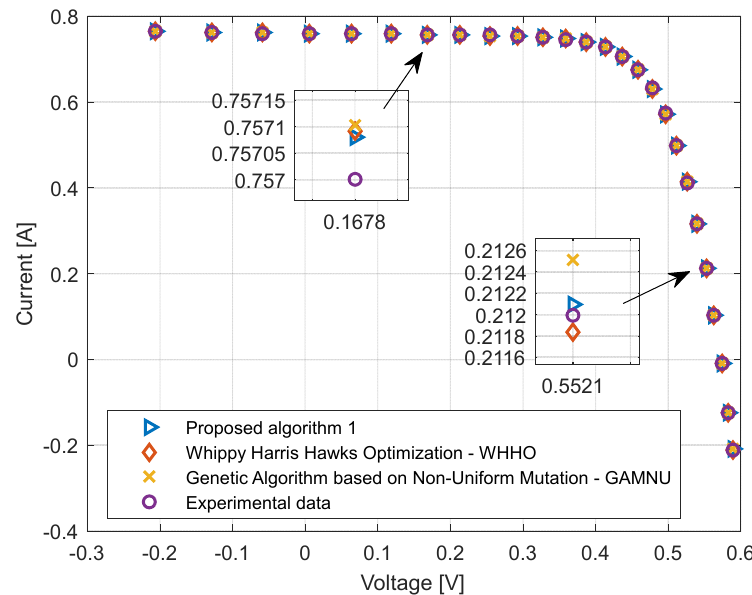
Figure 5. Current-voltage characteristics of the RTC France solar cell.